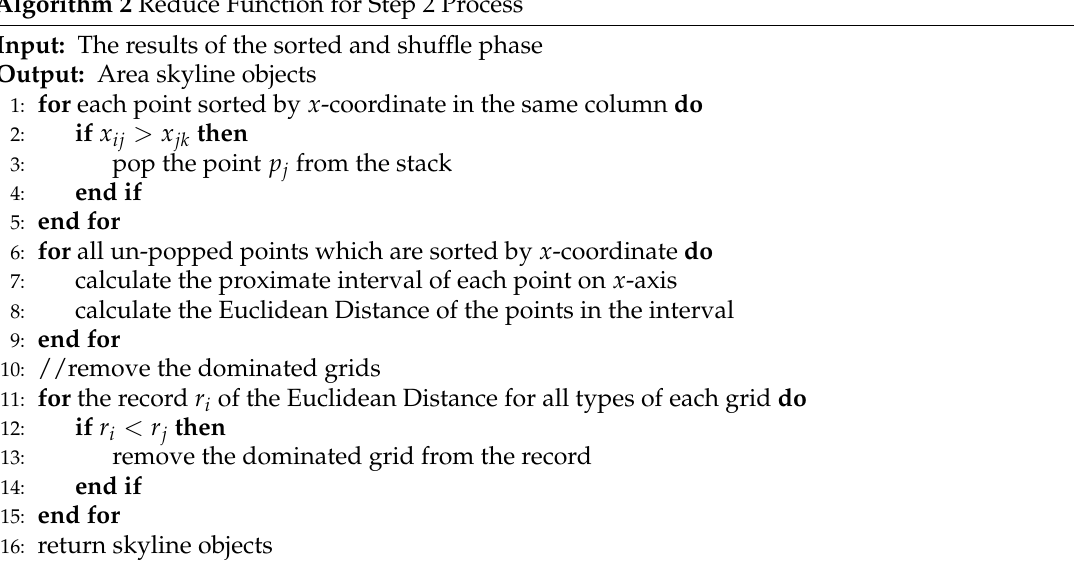
Algorithm 2 Reduce Function for Step 2